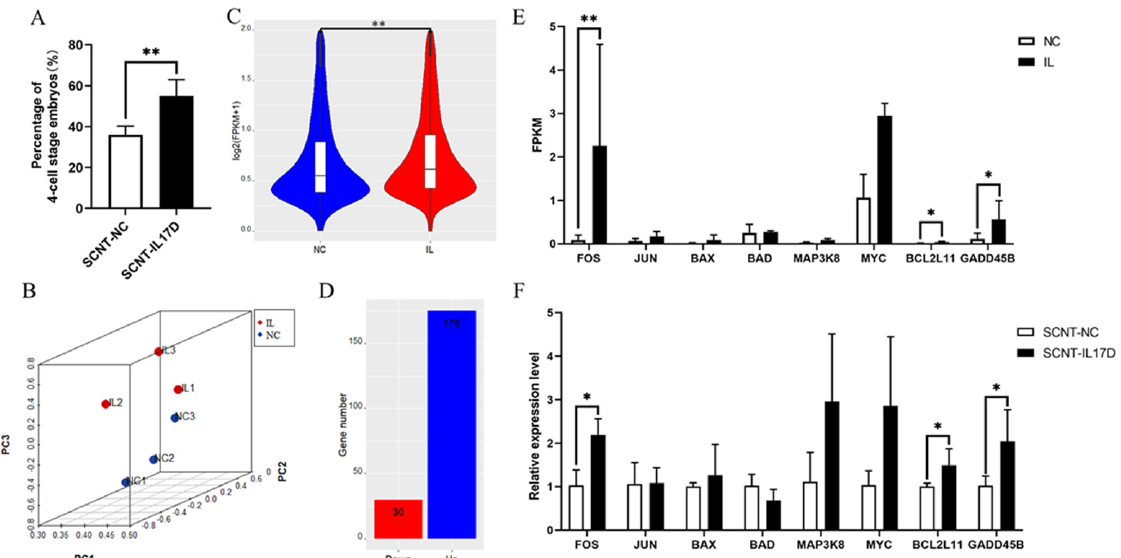
Figure 3. Transcriptome sequencing of SCNT-IL17D (IL) and SCNT-NC (NC) embryos at 4-cell stage. ( A ) Comparison of the percentage of embryos developing to 4-cell stage between SCNT-IL17D and SCNT-NC groups. ( B ) Principal component analysis (PCA) plot for six samples from IL and NC groups at 4-cell stage. Each sample was a mixture of 20 to 30 embryos. ( C ) Violin plot of mRNA levels of 6296 transcriptome sequencing-detected genes (with the sum of individual gene’s FPKM value >1) of IL and NC embryos at 4-cell stage. ( D ) Bar plot of differentially expressed genes (IL vs. NC) between IL and NC groups at 4-cell stage. ( E ) Transcriptome sequencing-detected mRNA expression levels of eight randomly selected genes in NC and IL group. ( F ) qRT-PCR -measured relative mRNA expression levels of the same eight genes in SCNT-NC and SCNT-IL17D embryos at 4-cell stage. Data were obtained from three independent replicates. Values were presented as mean ± SEM. * and ** means p < 0.05 and p < 0.01, respectively.